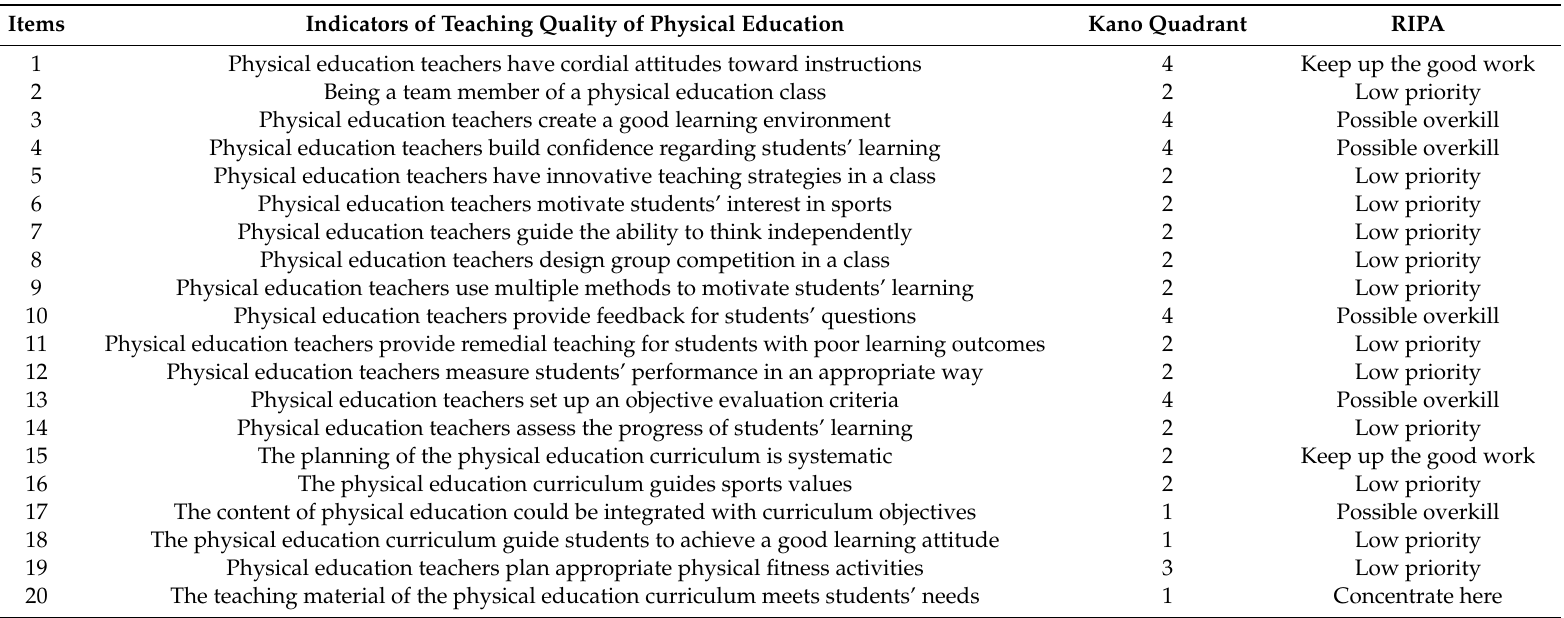
Table 2. Integrated RIPA and Kano model cross-analysis on teaching quality of physical